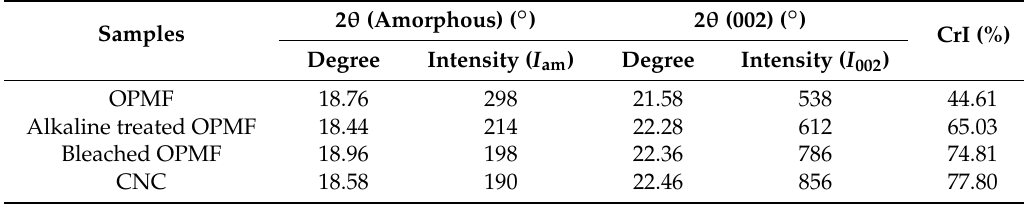
Table 2. Crystallinity index (%) of OPMF, alkaline treated OPMF, bleached OPMF and CNC.